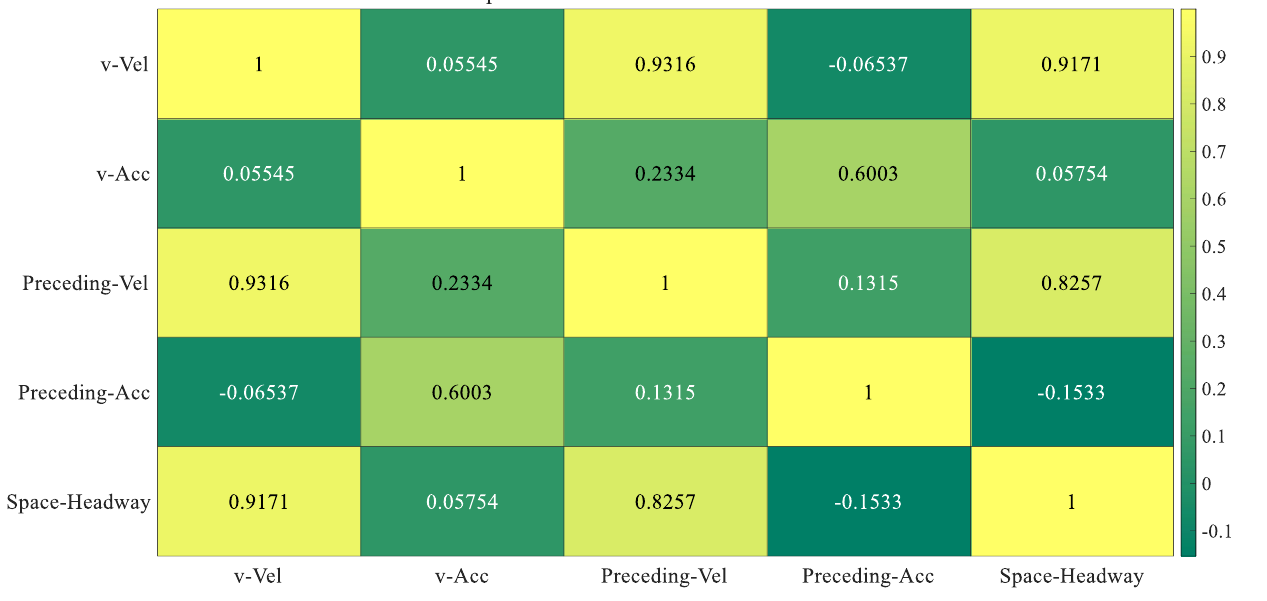
Figure 4. Kendall coefficient analysis results.